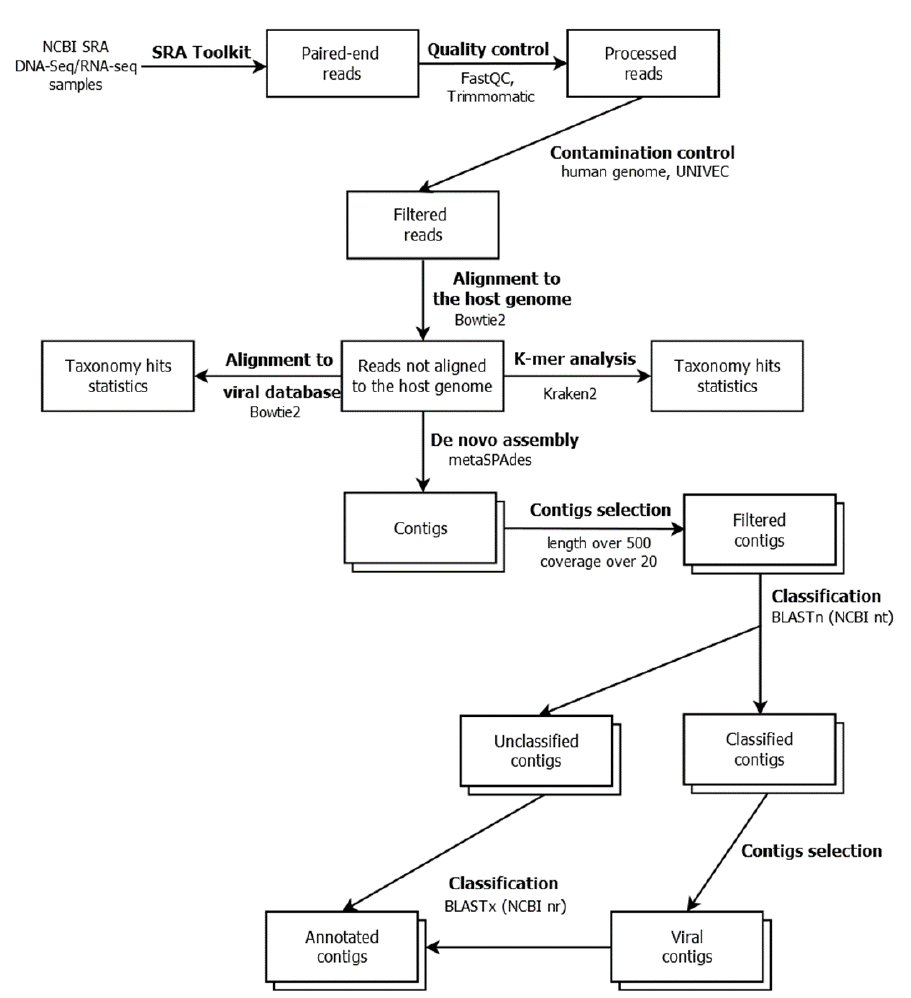
Figure 1. The software pipeline used in this work, with the analysis steps and their connections indicated and the programs used specified. https://github.com/starchevskayamaria17/uncoVir, accessed on December 2022.